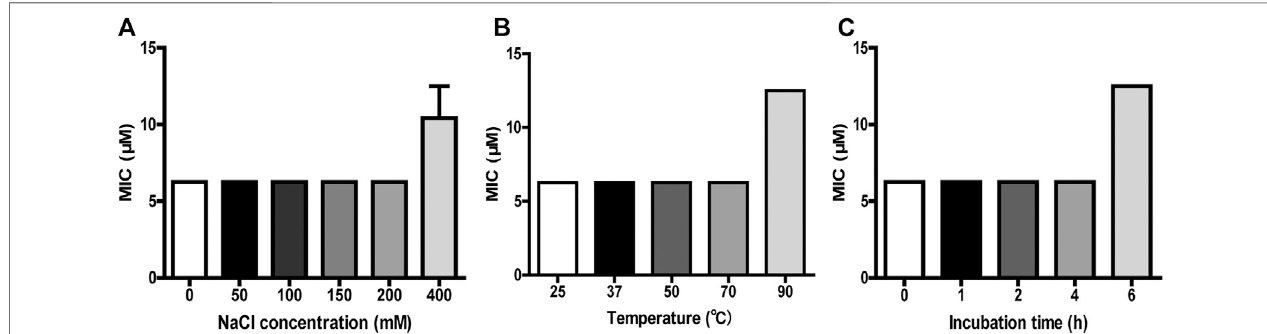
FIGURE 3 | Stability detection of FM-CATH. FM-CATH was incubated (A) with different concentrations of NaCl solution at room temperature for 1 h, (B) at the indicated temperatures for 1 h, or (C) with human serum [1:4 (v/v)] at 37 ° C for the indicated duration before its MICs against E. coli ATCC 25922 were determined. Data are expressed as mean ± SEM (n (cid:1)